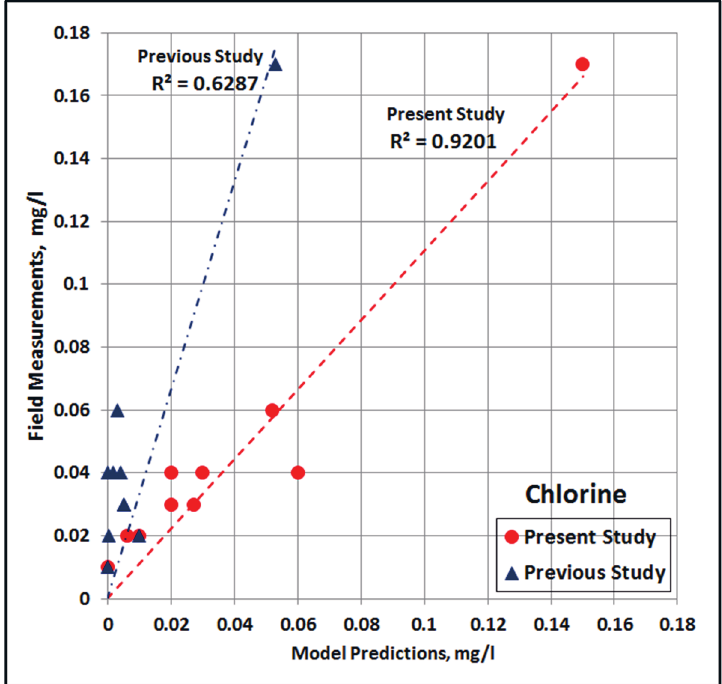
Figure 10. Comparison of GEMSS model predictions vs . field measurements for previous and present study chlorine decay rate